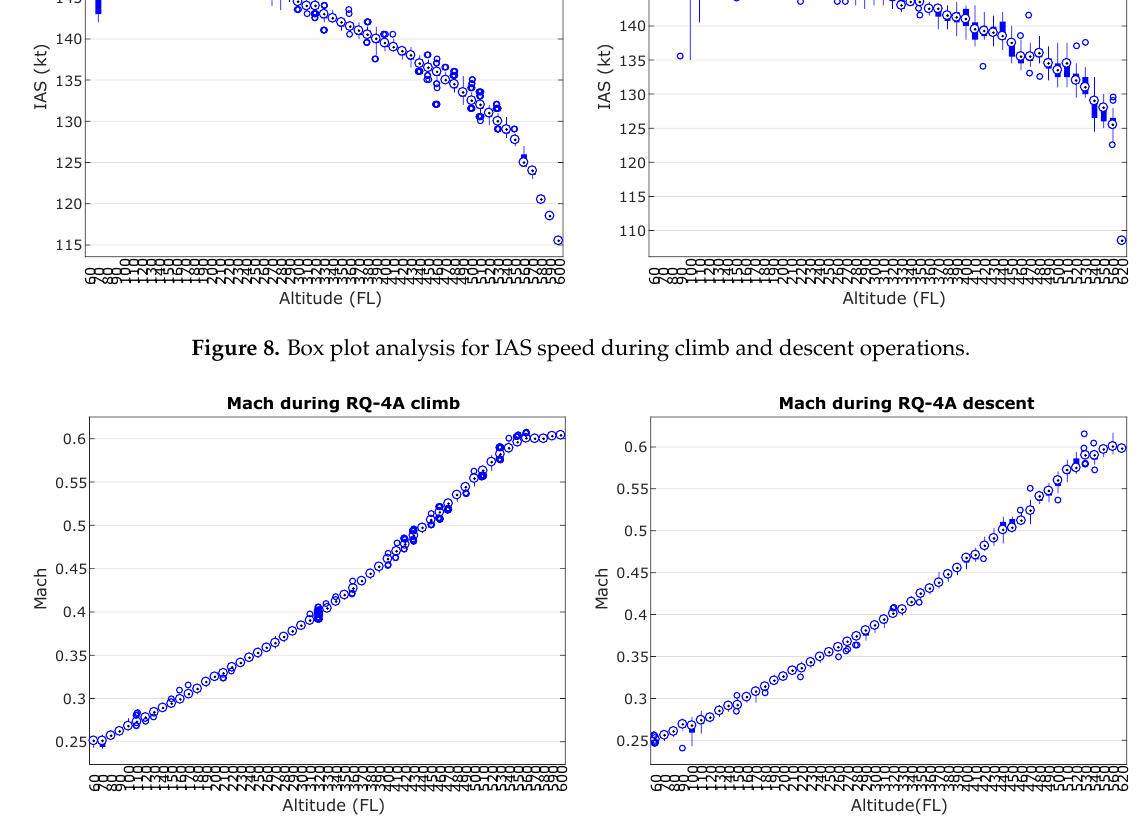
Figure 9. Box plot analysis for Mach speed during climb and descent